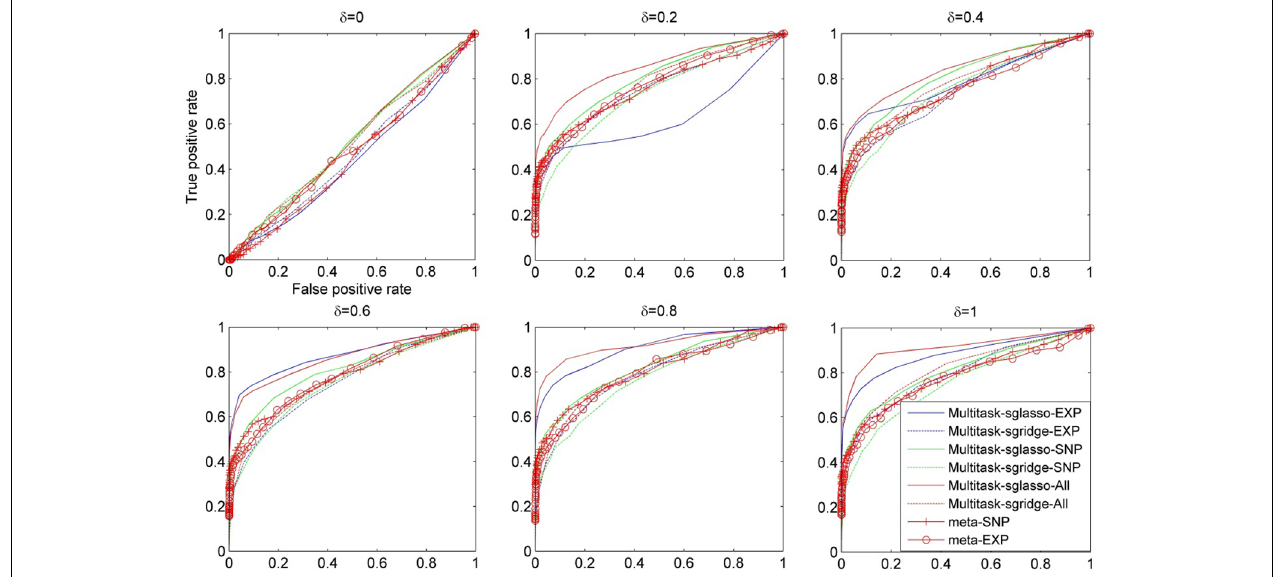
FIGURE 1 | The ROC curves for the comparison of eight cases: sparse multitask-sglasso and multitask-sgridge methods on three SNP datasets, expression datasets and all datasets, and meta-analysis on SNP and expression datasets, respectively.